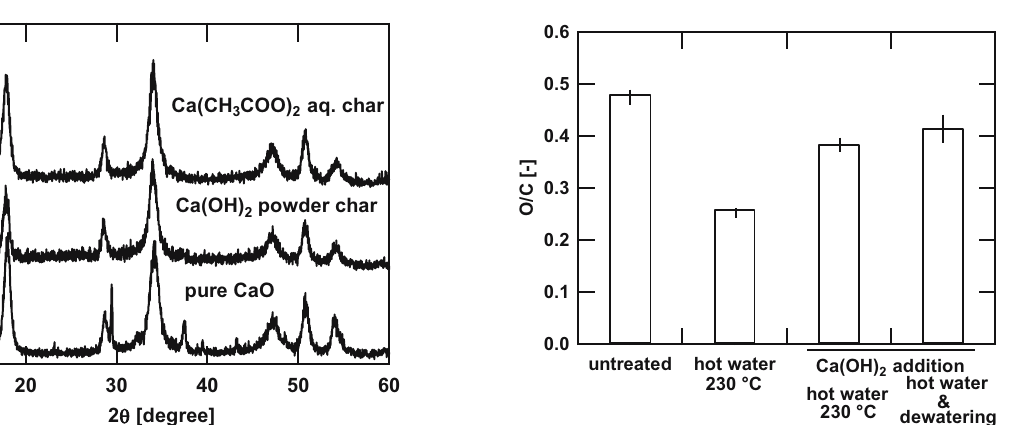
Figure 10: Changes in the O/C atomic ratio of the co ff ee grounds after the combined